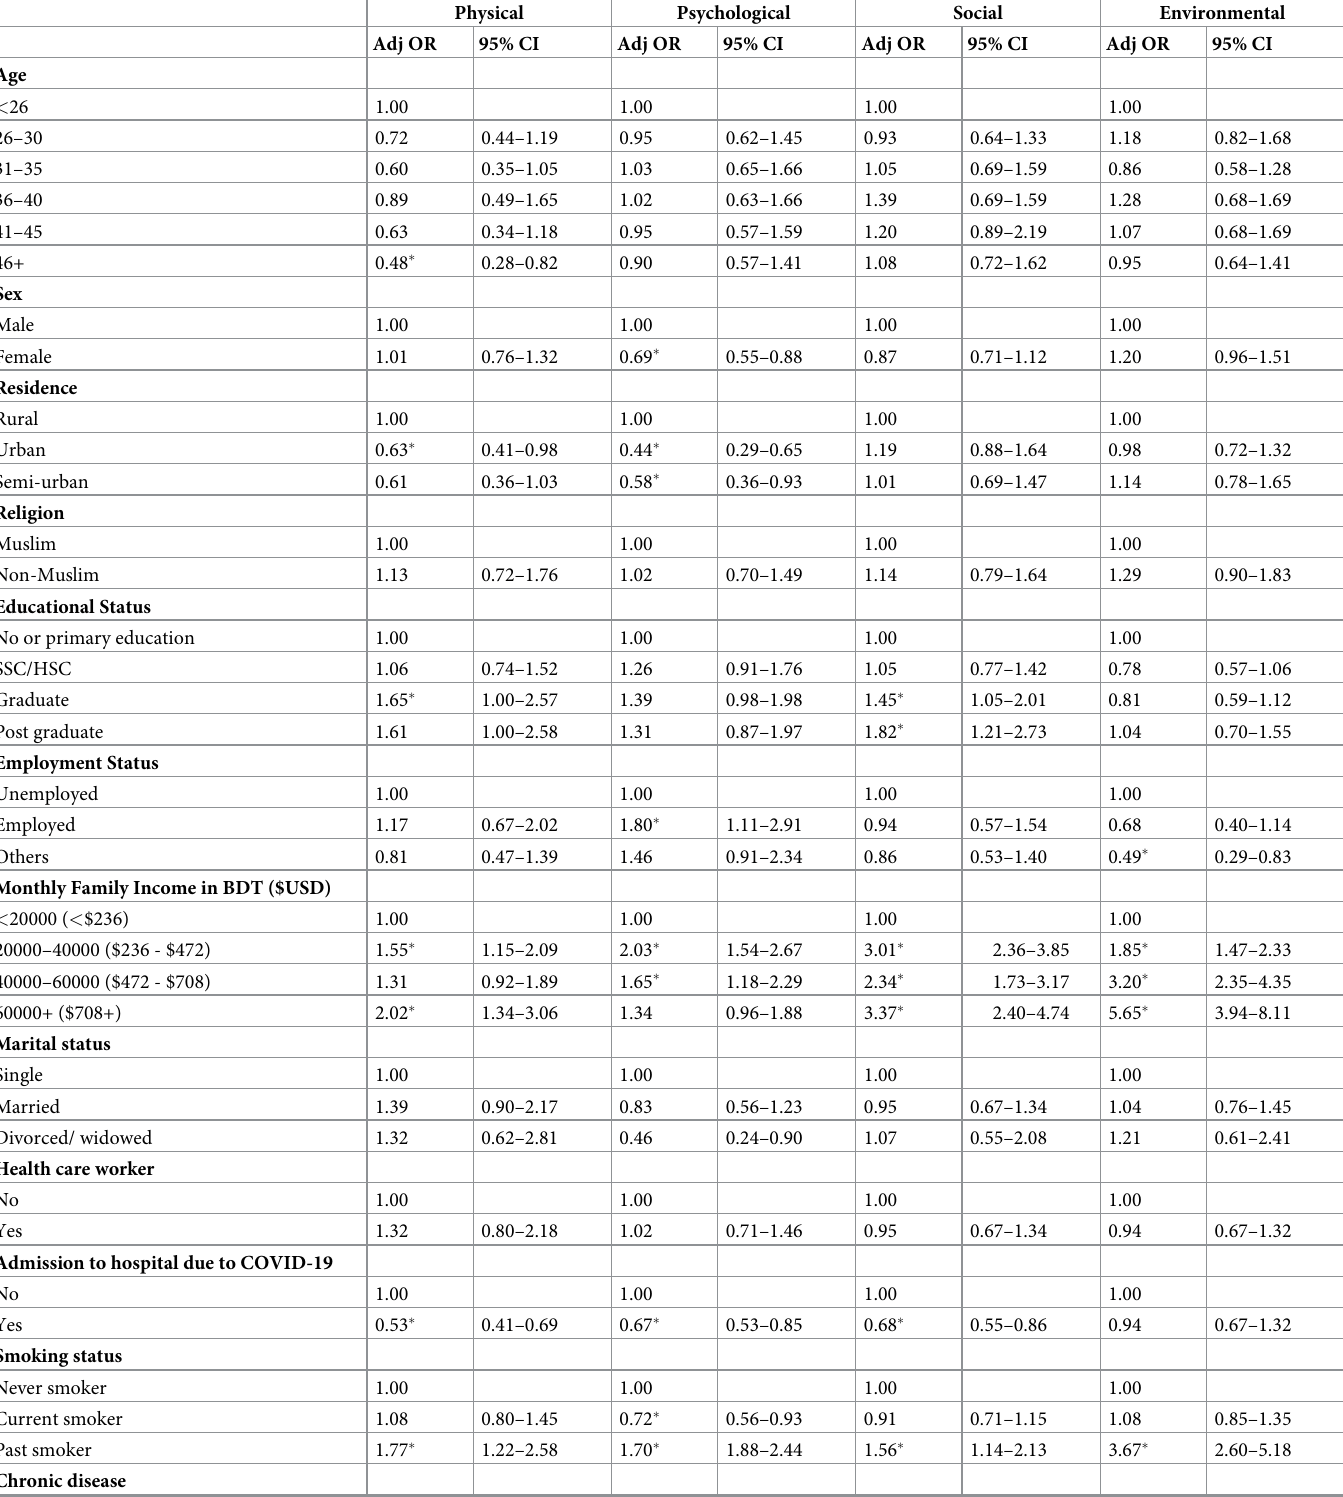
Table 6. Factors associated with each domain of WHOQOL-BREF among the study participants in multivariable logistic regression